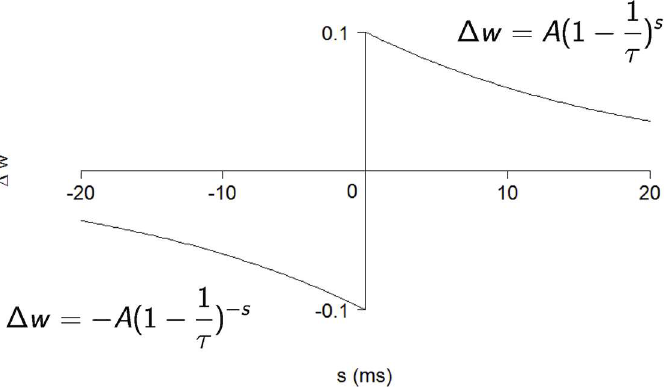
Fig 2. The Spike-Timing Dependent Plasticity (STDP) function governing the weight variation Δ w of the synapse from neuron a to neuron b depending on the relative spike timing s = t b − t a . A = 0.1; τ = 20